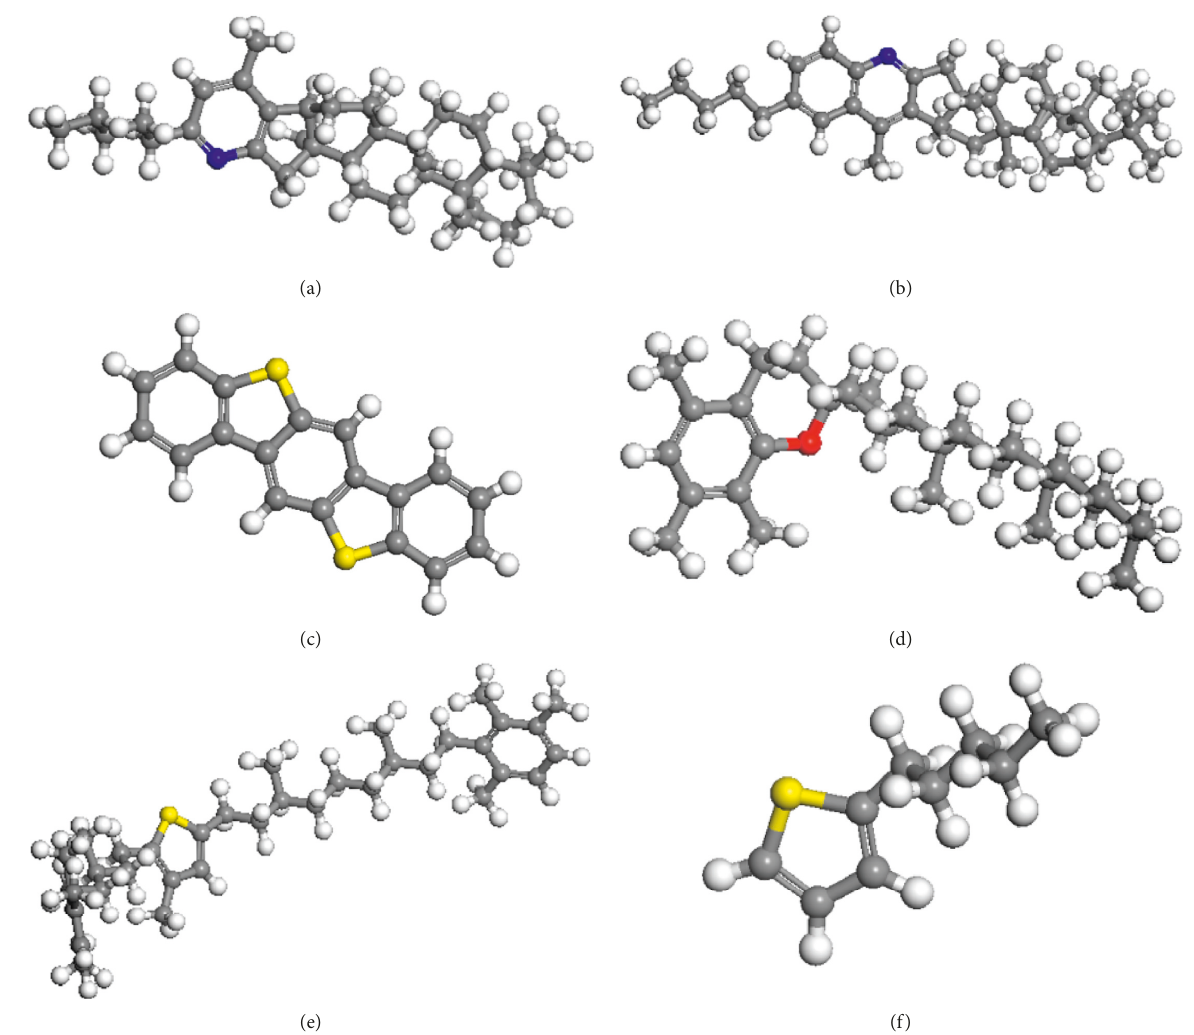
Figure 6: Typical molecular structures for polar aromatics [35, 40, 42, 43,